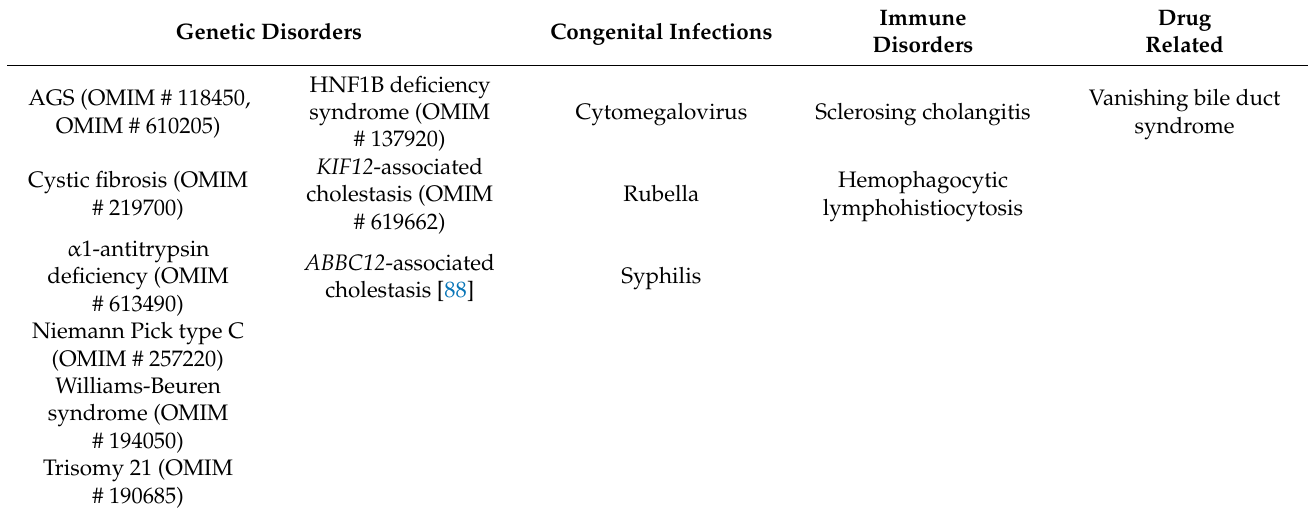
Table 4. Paucity of bile ducts and associated